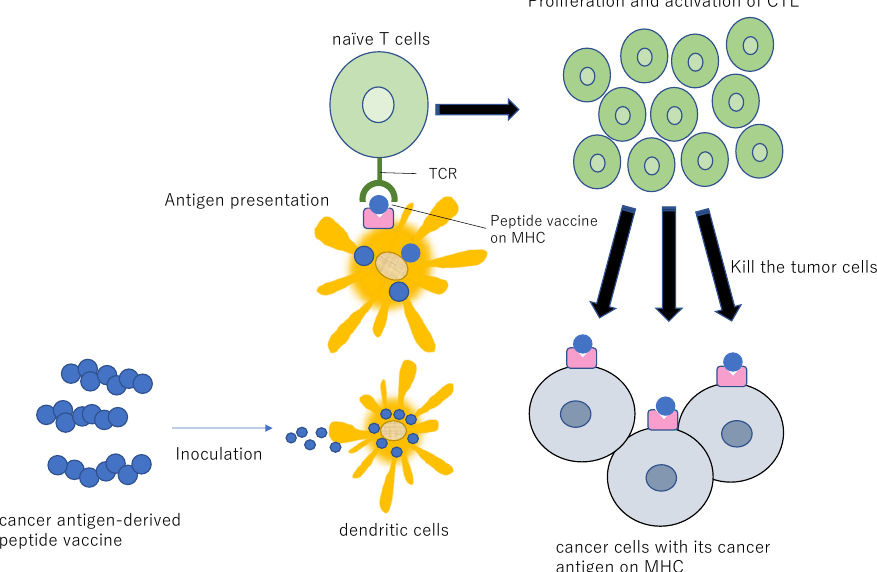
Figure 11. Diagram for peptide vaccine. If a peptide vaccine originating from a cancer antigen is inoculated into a patient, the peptide is taken up by the DCs, resulting in the presentation of the antigen to the CTL. This antigenic stimulus induces proliferation and activation of CTL, resulting in specific injury/killing of the cancer cells presenting the cancer antigen peptide.